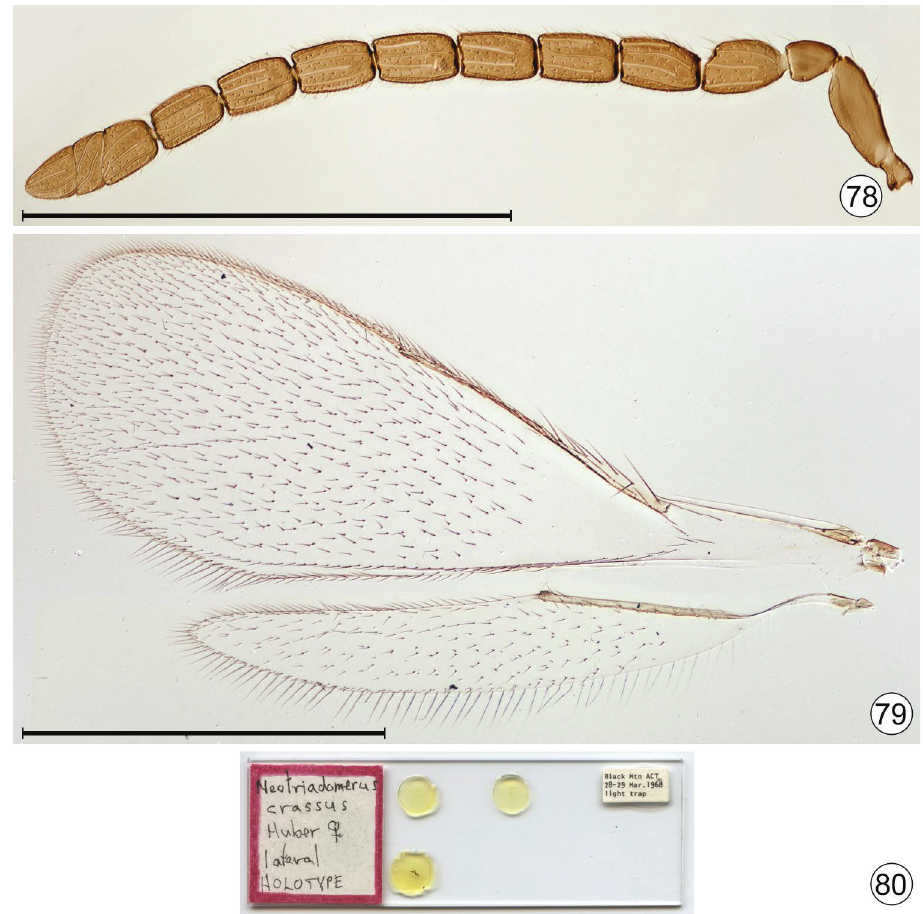
Figures 78–80. Neotriadomerus crassus , holotype. 78 antenna 79 wings 80 type slide. Scale bar = 500 μm. light brown. Head. Width not measurable (Fig. 76). Antenna. Fl slightly longer than 1 fl , apparently with 8 mps; fl –fl with 8 mps (possibly 9 or 10 on fl and fl ); clava 2 2 8 7 8 with about 22 mps, 8 on first, 6 on second and 8 on third segment (Fig. 78). Antennal measurements (n=1), length/width (ratio of flagellar segments): scape 145/47 (3.10), pedicel 58/42 (1.37), fl 86/56 (1.53), fl 84/52 (1.60), fl 82/50 (1.63), fl 81/50 1 2 3 4 (1.63), fl 86/53 (1.62), fl 82/51 (1.59), fl 78/50 (1.57), fl 76/48 (1.58); entire clava 5 6 7 8 143/55 (2.59), with segments 1–3 length [measured along dorsal margin], 46, 35, and 64. Mesosoma. Width not measurable, length 580. Wings. Fore wing length 1154, width 397, length/width 2.91, longest marginal setae 46; cubital line extending to just proximal to base of parastigma (Fig. 79). Hind wing length 942, width 130, longest marginal setae 66. Legs. Protibia with 6 short, thick pegs along its length and trans- verse row of 4 abutting pegs apically (as in Fig. 53). Metasoma. Metasoma (Fig. 77) in lateral view 224 at highest point, gradually widening from petiole to about 0.6